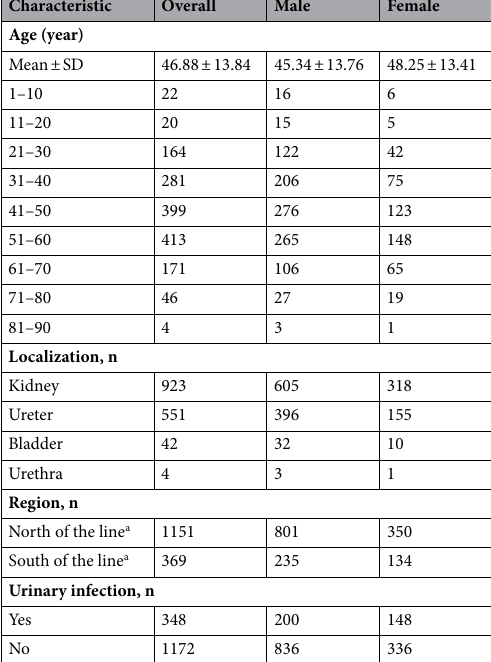
Table 1. Characteristics of urinary stones of according to gender of 1520 patients. a The Qinling Mountain- Huaihe River Line.